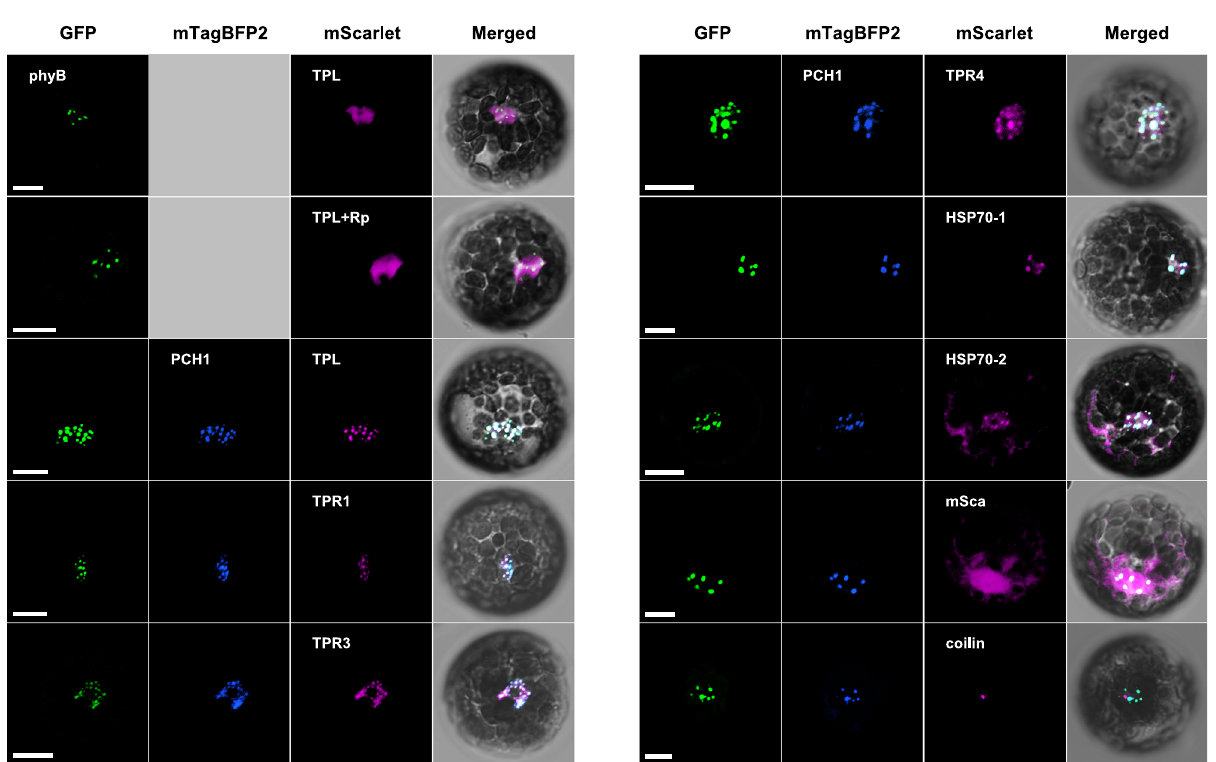
independent nuclear body. Rp indicates red light pulse (25 μ mol/m 2 /s for 30min) treated protoplast sample image to observe localization of the TPL under the high red tofar-redlightratio.Thetransformed protoplastswereculturedfor16hunder continuous white light (10 μ mol/m 2 /s). Scale bars=10 μ m. The representative images were shown in observation of at least 30 independent protoplasts. The observed fractions of the protoplasts showing co-localization are listed in Sup- plementary Data 2. The quantitative fl uorescent intensity pro fi les of the co- localization are in Supplementary Fig. 7. Source data are provided as a Source Data fi